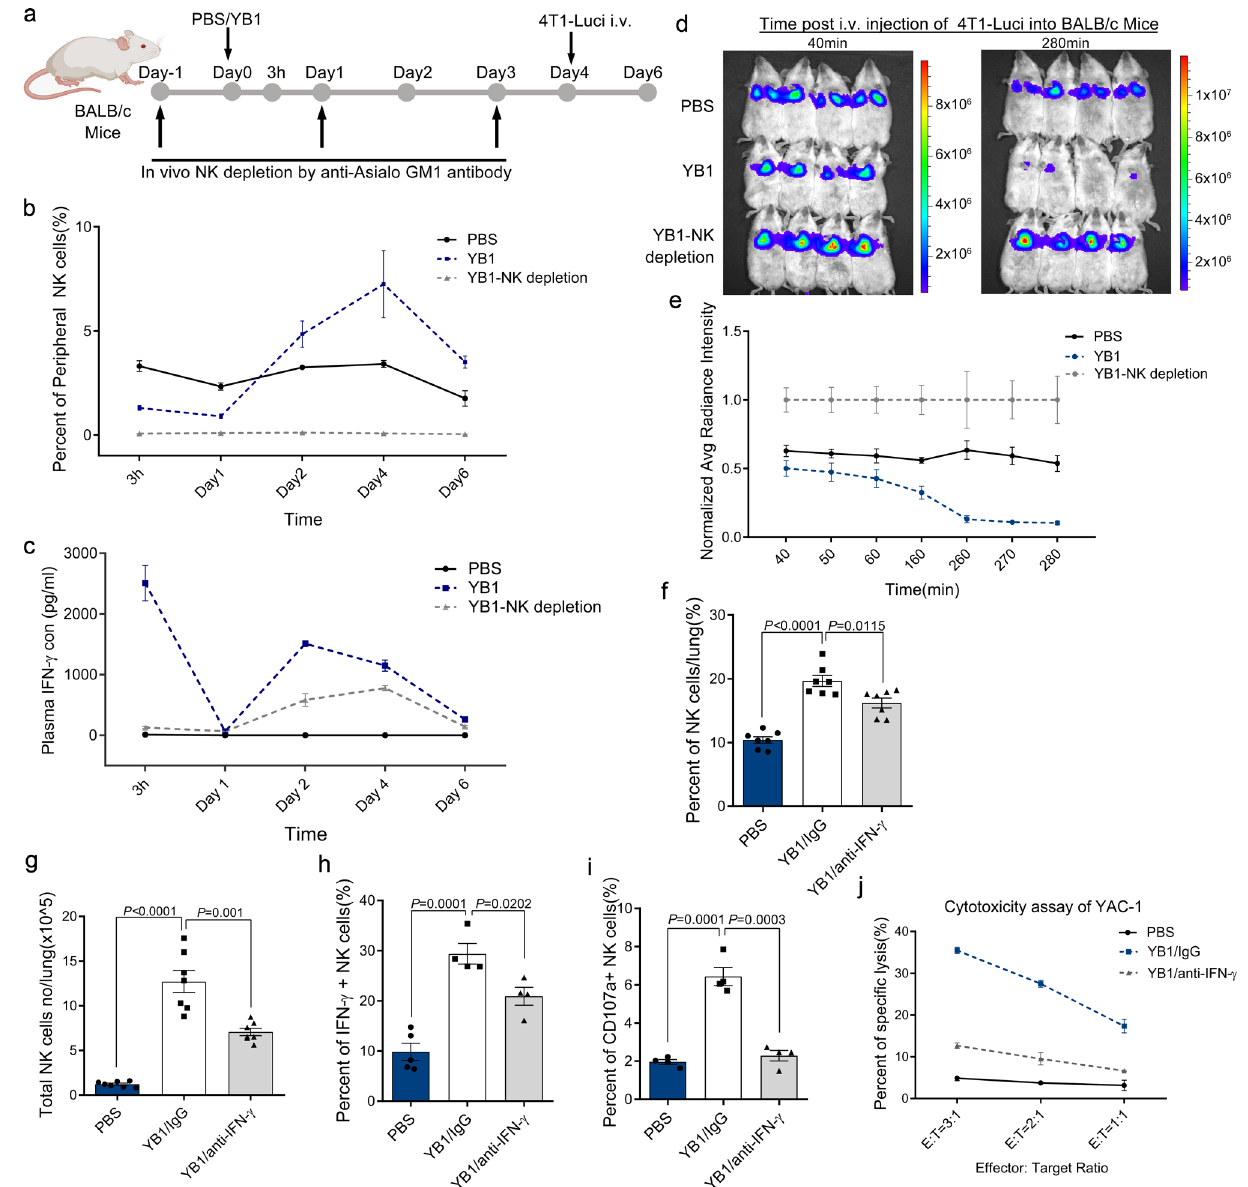
Fig. 7 NK cells and IFN- γ are indispensable for Salmonella YB1 to suppress cancer metastasis. a BALB/c mice were divided into three groups and treated with PBS, YB1, or YB1 plus NK depletion antibody, respectively ( n = 4 per group). b , c NK cell depletion ef fi ciency ( n = 3 mice per group) and plasma IFN- γ concentration ( n = 4 mice per group) were monitored at 3 h, day 1, 2, 4, and 6. d , e On the morning of day 4, 4T1-Luci cancer cells were i.v. injected into BALB/c mice and tracked by live imaging ( n = 4 mice per group). Data were normalized to YB1-NK depletion group. f – i BALB/c mice were divided into three groups and treated with PBS, YB1 (YB1/IgG) or YB1 plus IFN- γ depletion antibody (YB1/anti-IFN- γ ), respectively. All mice were killed on day 5 after YB1 or PBS treatment and lung-in fi ltrating immune cells were applied to fl ow cytometric analysis. f The percentage of NK cells to all immune cells in lung across samples ( n = 7 per group). g The absolute total number of NK cells per lung across samples ( n = 7 per group). Total immune cell numbers were measured by trypan blue exclusion and then multiplied by the percentage of NK cells determined by FACS analysis to give the absolute number of NK cells for each lung. h Flow cytometric analysis of IFN- γ production in lung-in fi ltrating NK cells across samples after co-culture with PMA and Ionomycin ex vivo for 5 h ( n = 5 for PBS group, n = 4 for YB1/IgG and YB1/anti-IFN- γ groups). i Flow cytometric analysis of CD107a expression on lung-in fi ltrating NK cells across samples after co-culture with YAC-1 cells ex vivo for 5 h ( n = 4 mice per group). j Cytotoxicity of lung-in fi ltrating NK cells against YAC-1 target cells at the indicated NK : Yac-1 (E : T, Effector : Target) ratios ( n = 3 biological replicates). All data are presented as mean values± SEM. All p -values were derived using two-tailed unpaired t -tests. Displayed is one representative experiment of two independent experiments, except for f , g (combined results of two independent experiments). Source data are provided as a Source Data fi